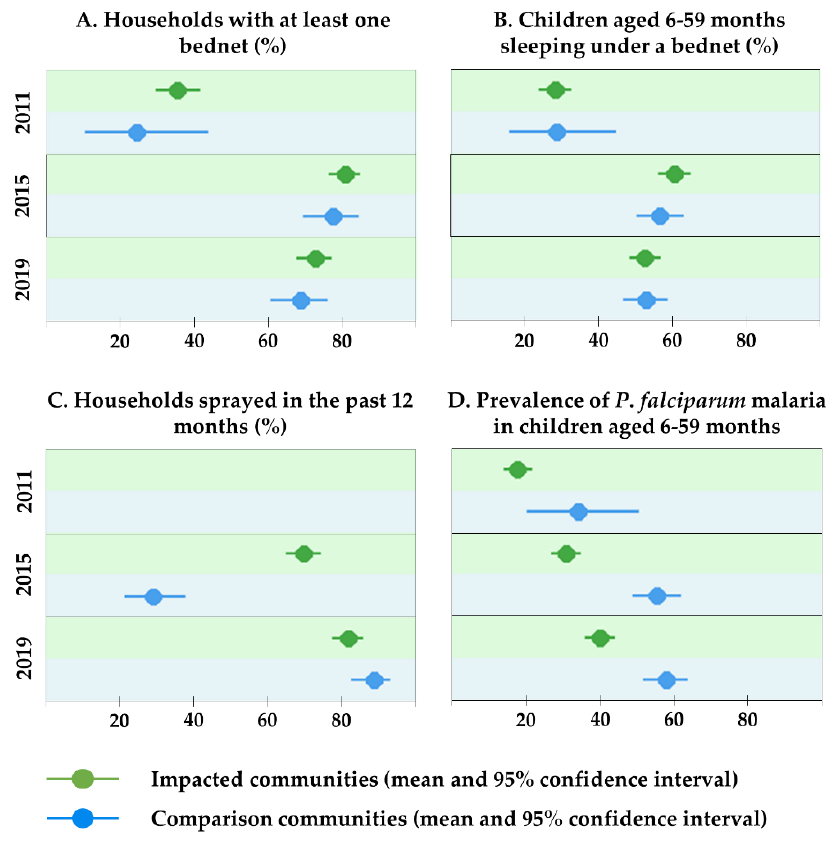
Figure 2. Vector control and malaria-related indicators, Trident project, Zambia (2011, 2015, 2019).